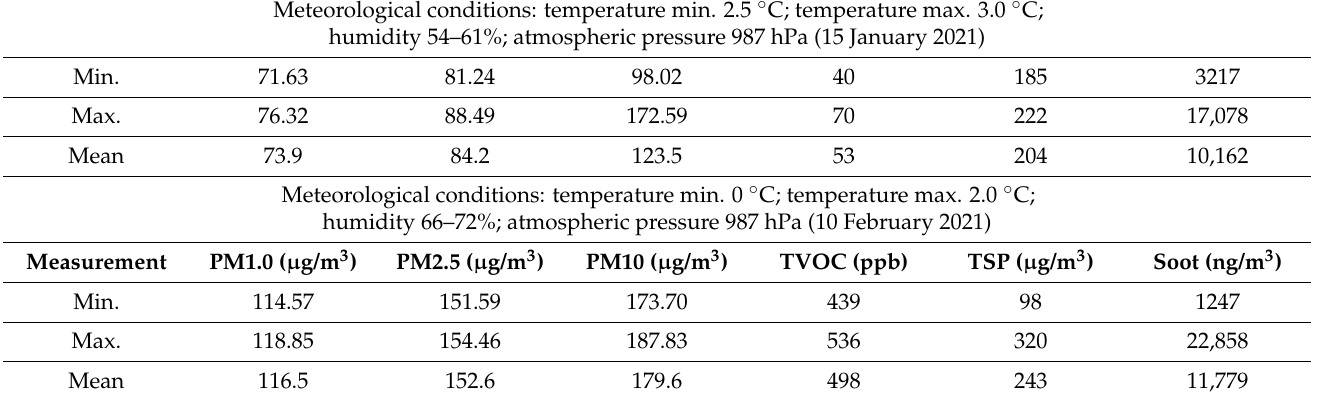
Table 2. Concentrations of PM, TSP, TVOC and soot determined in the winter season in Pszczyna—Piasek.